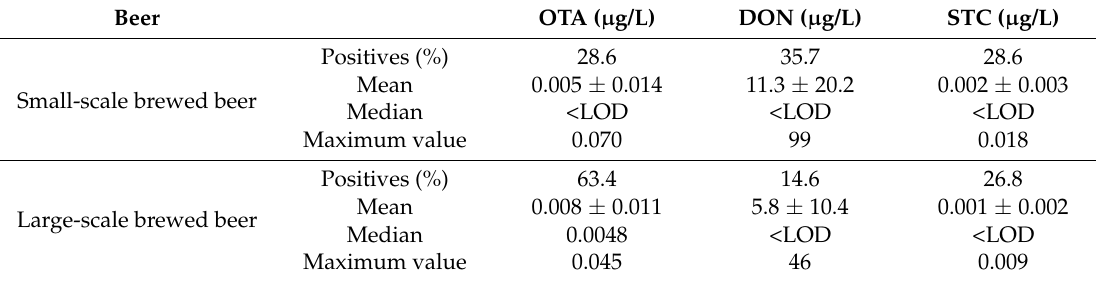
Table 1. Descriptive statistics for ochratoxin A (OTA), deoxynivalenol (DON), and sterigmatocystin (STC) in small- and large-scale brewed beer.